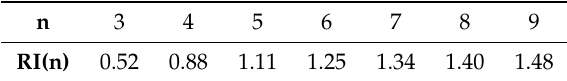
Table 4. Random consistency index